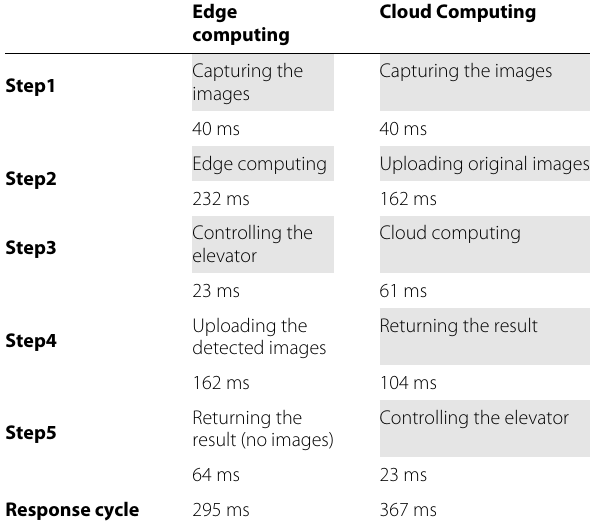
Table 5 The response times of edge computing and